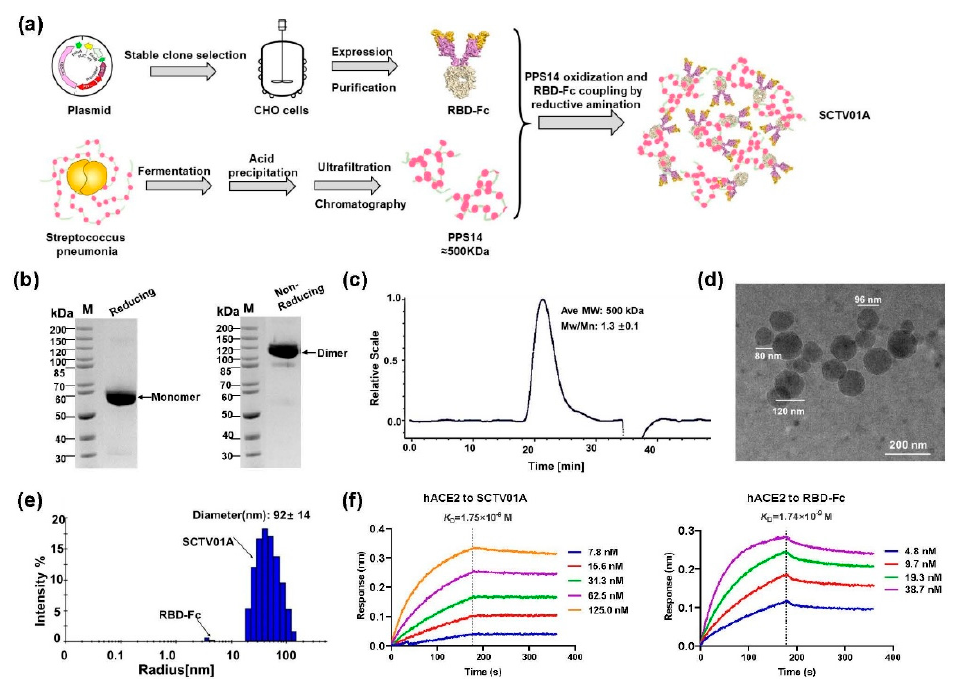
Figure 1. Design and characterization of SCTV01A. ( a ) Experimental design and workflow for the preparation of SCTV01A. The SARS-CoV-2 RBD-Fc was expressed in CHO cells. PPS14 was produced from S. pneumoniae by the acid precipitation method and conjugated with RBD-Fc utilizing the reductive amination method. ( b ) The molecular weight and purity of RBD-Fc were detected by NuPAGE. ( c ) The purity, molecular weight (MW), and polydispersity of SCTV01A were tested by SEC-MALS. ( d ) TEM of SCTV01A showed nanoparticles with heterogeneous diameters (scale bar = 200 nm). ( e ) The molecular diameter of SCTV01A and RBD-Fc was identified by DLS. ( f ) Binding affinity of SCTV01A and RBD-Fc to human ACE2 receptor using the BLI method.